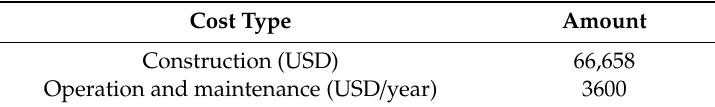
Table 4. Cost estimation (market prices).